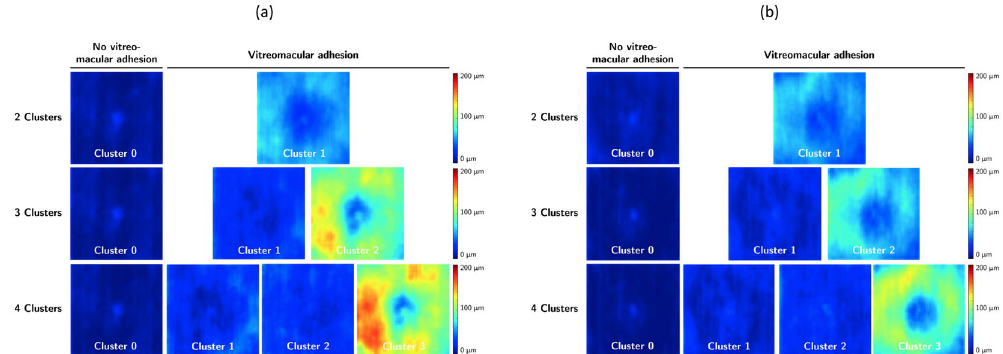
Figure 2. Unsupervised clustering of vitreomacular interface configurations. Panel (a) shows clusters for branch retinal vein occlusion patients; Panel (b) for central retinal vein occlusion. The Cluster 0 contains eyes without vitreomacular adhesion, including both completely attached vitreous and complete posterior vitreous detachment. Clusters 1–3 contain eyes with vitreomacular adhesion. If more clusters are chosen, the unsupervised algorithm differentiates between shallow and steep vitreomacular adhesion in separate